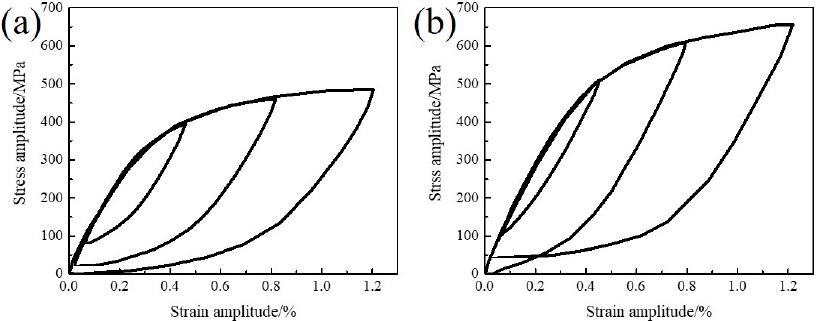
Figure 7. The superimposed hysteresis loops of the specimens at different strain levels: ( a ) novel steel and ( b ) 30SiMn2MoV.